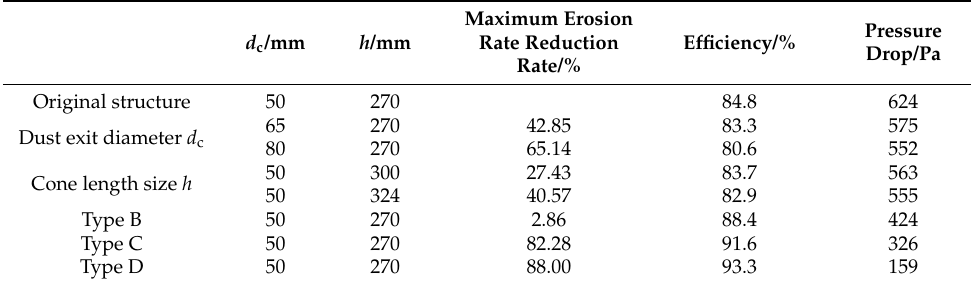
Table 1. Comparisons of maximum erosion rate and separation performance for different cyclones. d c